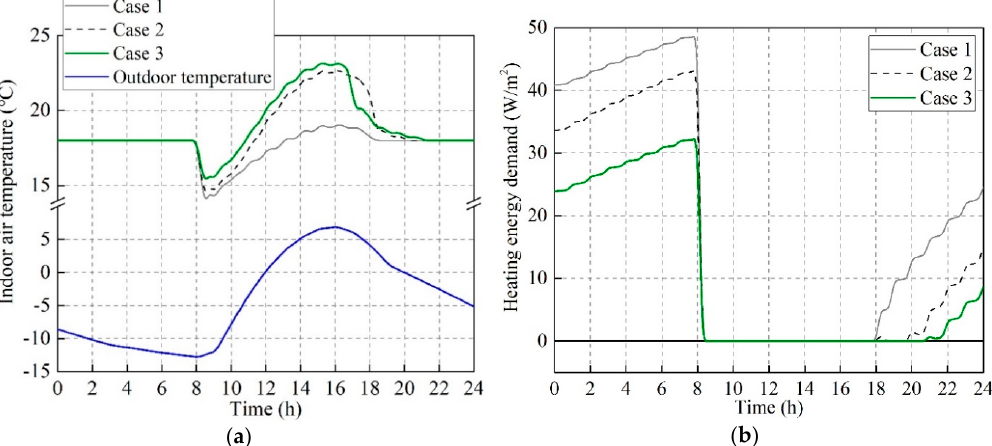
14 of 23 ( b ) Figure 11. TRNSYS model for Case 1 and Case 2. ( a ) TRNSYS model for Case 1; ( b ) TRNSYS model for Case 2. 3. Results and Discussion 3.1. Energy Saving Potential of HHCF Figure 12 shows the indoor air temperature and the heating need on the heating design day (21 January) predicted by the simulations. As seen in Figure 12, the studied room with the proposed HHCF (Case 3) has a higher temperature and a lower heating need than the other two passive measures (Cases 1 and 2). Table 2 summarizes the indoor air temperature and the total heating need of the studied room during the heating season. As shown in Table 2, during the heating season, the mean indoor air temperature for the studied room with the proposed HHCF is 18.6 °C, which is 1.1 °C and 0.4 °C higher than those of the direct solar heat gain window and the Trombe wall,